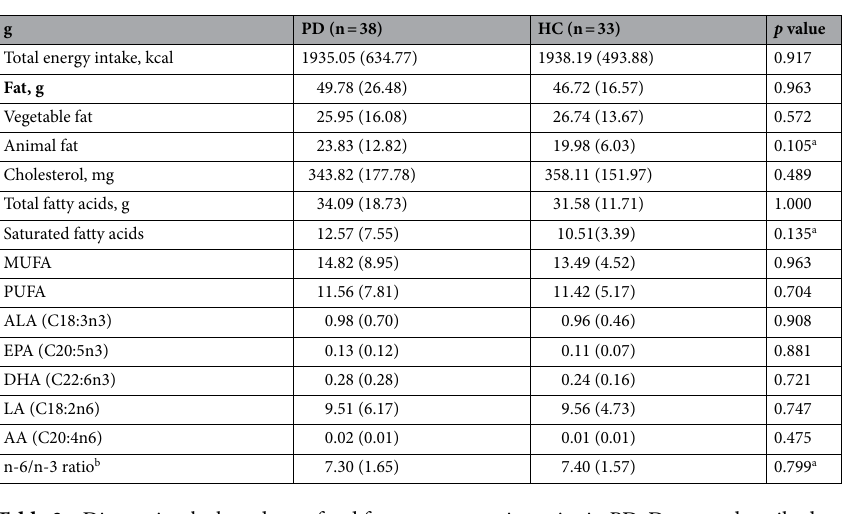
Table 3. Dietary intake based on a food frequency questionnaire in PD. Data are described as mean (standard deviation). For group comparisons, the Mann–Whitney U test was used if not otherwise indicated. PD Parkinson’s disease, HC healthy control, MUFA monounsaturated fatty acid, PUFA polyunsaturated fatty acid, ALA alpha-linolenic acid, EPA eicosapentaenoic acid, DHA docosahexaenoic acid, LA linoleic acid, AA